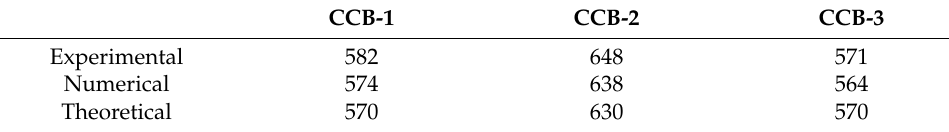
Table 6. Bearing capacities obtained from experimental, numerical, and theoretical results (unit: